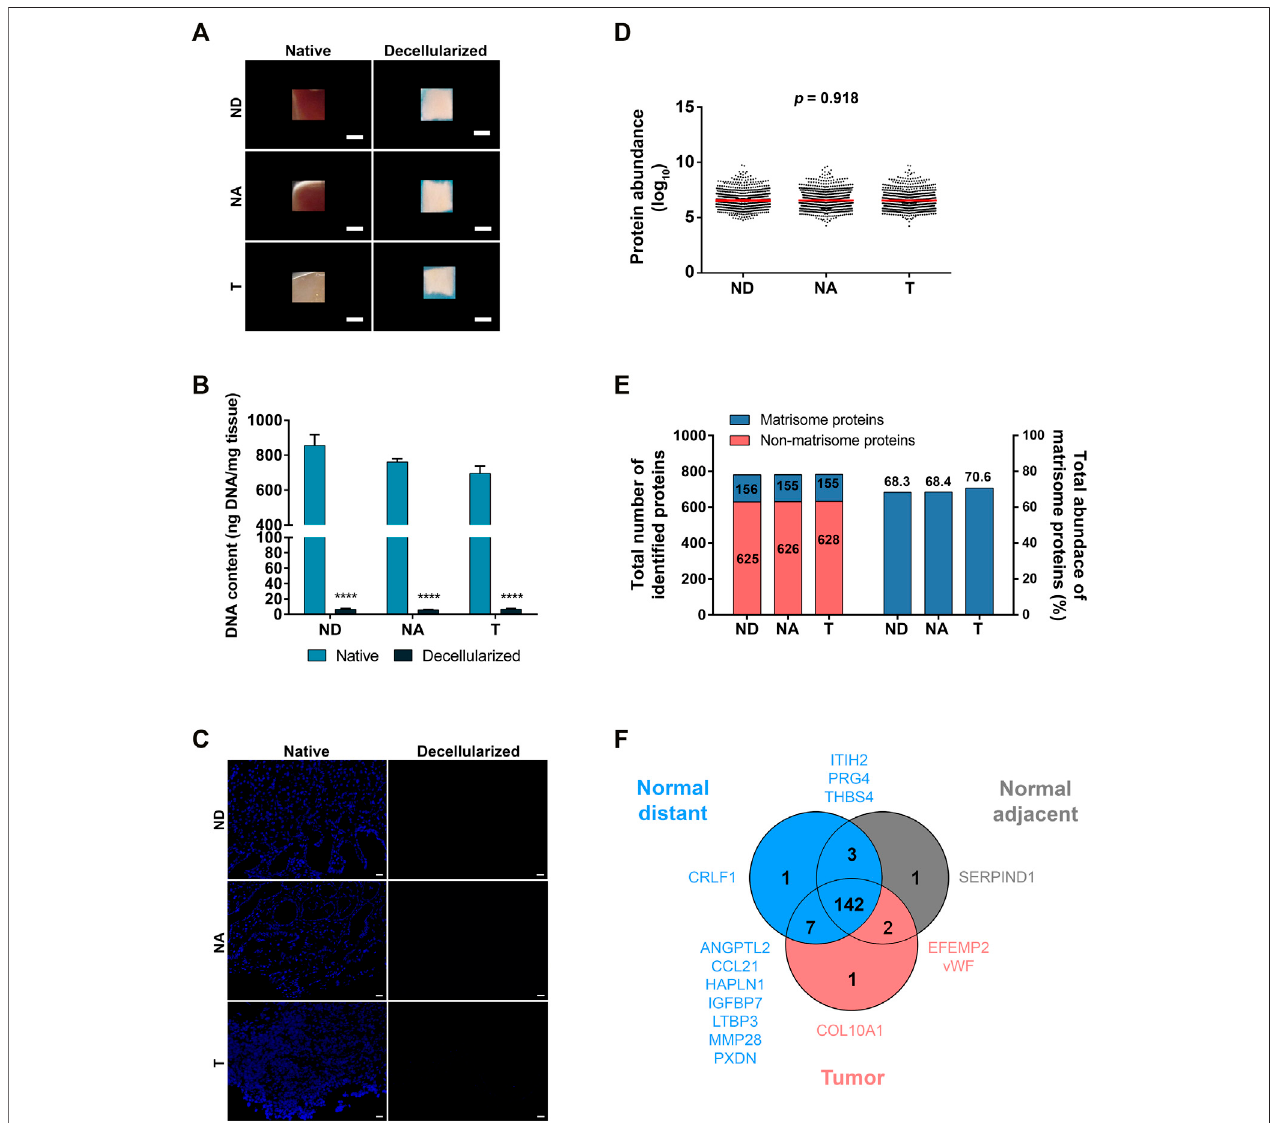
FIGURE1| CharacterizationandproteomicanalysisofdecellularizedgastricECM. (A) Representativemacroscopicimagesofnormaldistant(ND),normaladjacent (NA) and tumor (T) samples from human gastric mucosa before and after decellularization; scale bar = 1 mm. (B) DNA quanti fi cation of native and decellularized ECM samples ( n = 3). Data are shown asmean ± SD, **** p < 0.0001. (C) Representative images ofDAPI staining of native and decellularized samples; scale bar = 20 µm. (D) Log 10 of normalized abundance distribution for all identi fi ed proteins in decellularized samples. (E) Total number of matrisome and non-matrisome proteins identi fi ed in decellularized ECM, with the corresponding abundance (%) of each set of matrisome proteins. (F) Venn diagram with the number of matrisome proteins identi fi ed in each tissue in at least 1/3 of the samples ( n = 9). We have identi fi ed a gastric matrisome signature composed of 153 proteins (in blue) and a tumor-speci fi c ECM signature with three proteins (in red). Proteins present in only one or two ECM sets are speci fi